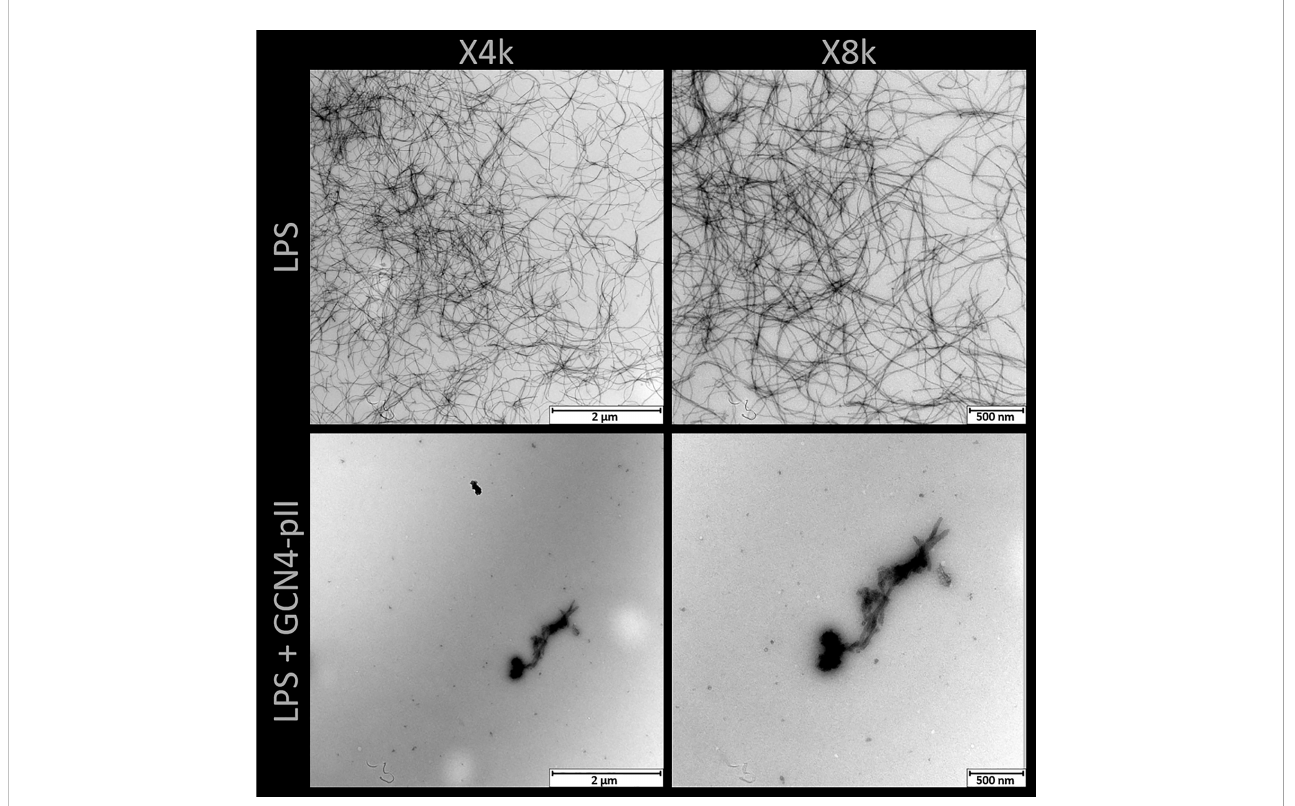
FIGURE 7 TEM of rough LPS from S. typhimurium with and without GCN4-pII present in a 1:4 stoichiometric ratio. LPS alone forms worm-like micelles with lengths up to several hundred nanometers. Addition of GCN4-pII breaks down the worm-like structure, leaving occasional fragmented micelles.